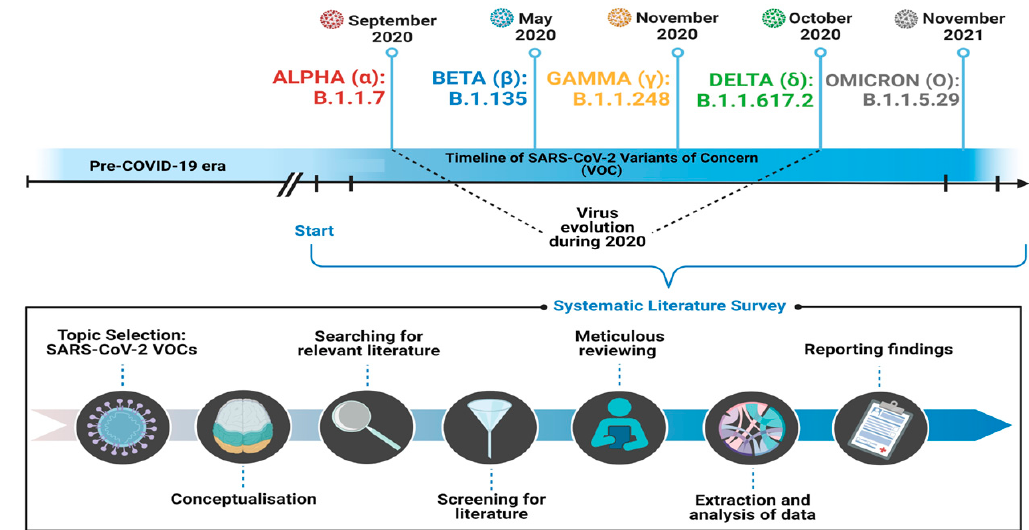
Figure 1. Conceptual framework of the study.